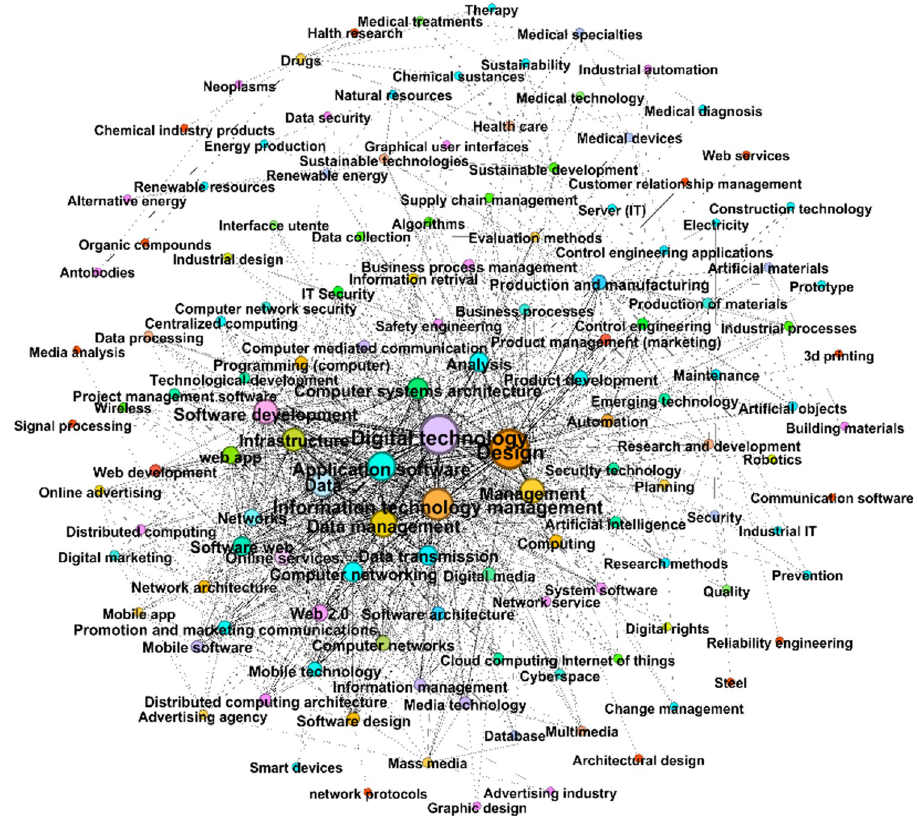
Fig 6. The network between specializations based on common